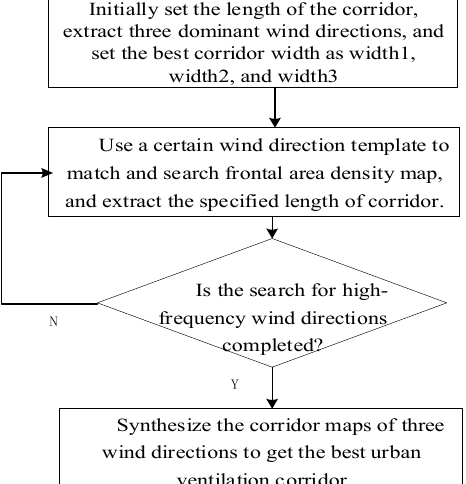
Figure 12. Flow chart of the optimal width for automatic mining of an urban ventilation corridor. Initially set the length of the corridor, extract three dominant wind directions, and set the best corridor width as width1, width2, and width3